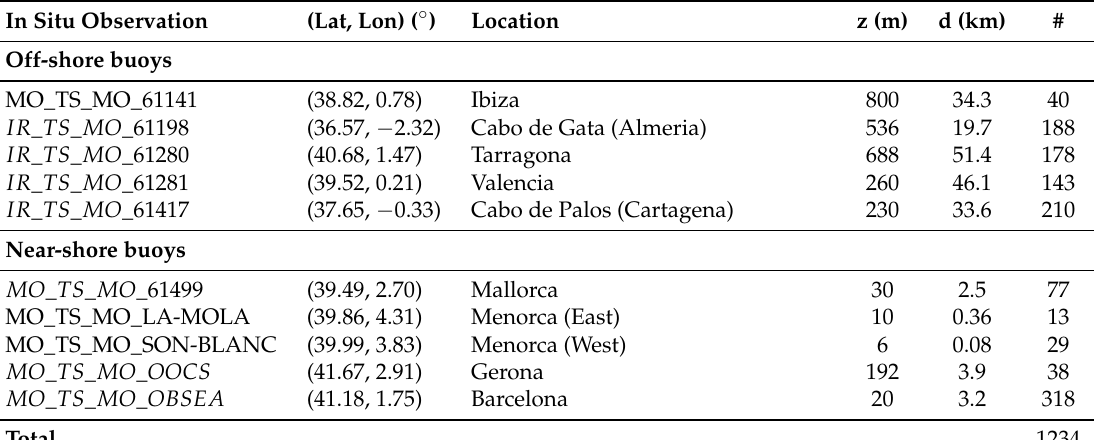
Table 3. Example subset of reprocessed in situ mooring observations obtained from [22] in the Western Mediterranean Sea. The columns represent (from left to right): the official name of the dataset in the Copernicus Marine registry, latitude and longitude of the platform location, name of the closest city or region, water depth in that point (z), distance to nearest shore (d), and number of observations matching satellite data from 2015 (#).